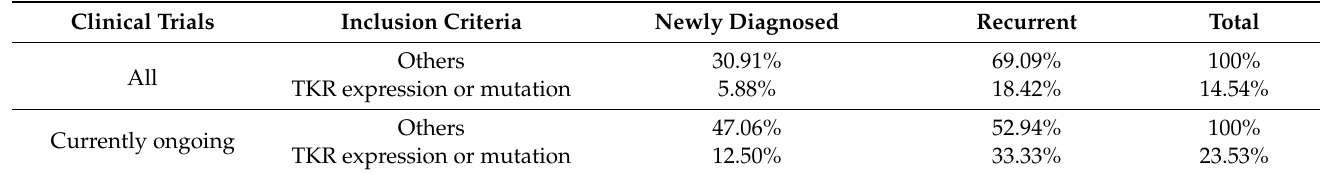
Table 4. Inclusion criteria (%) in GBM TKIs clinical